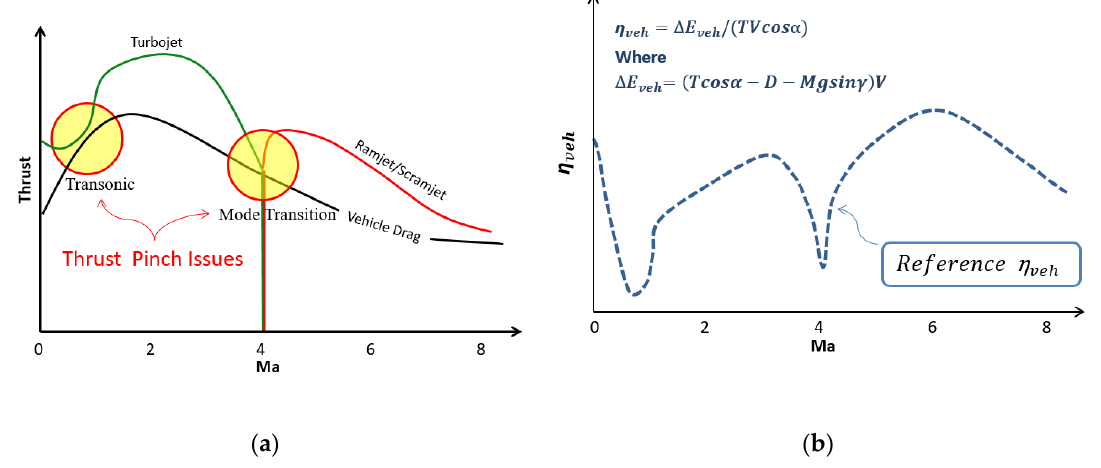
Figure 1. ( a ) Thrust pinch in transonic and mode transition; ( b ) Vehicle efficiency.